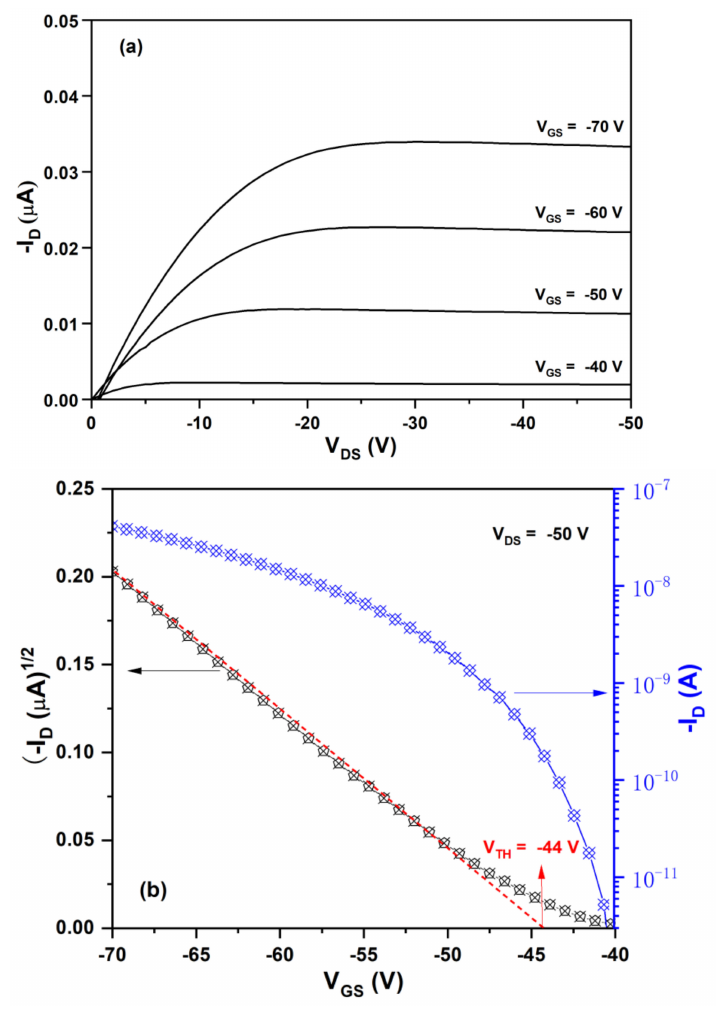
Figure 8. ( a ) Output characteristics and ( b ) transfer characteristics of the OFET device based on BDT(DBTOTTH) 2